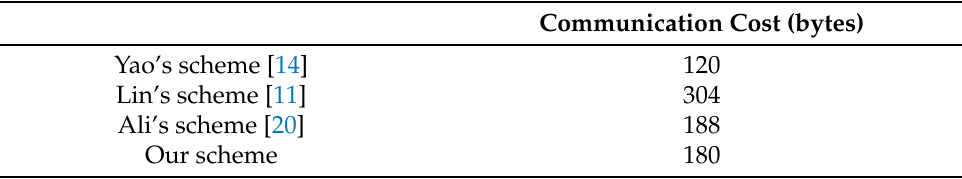
Table 6. Comparison of communication